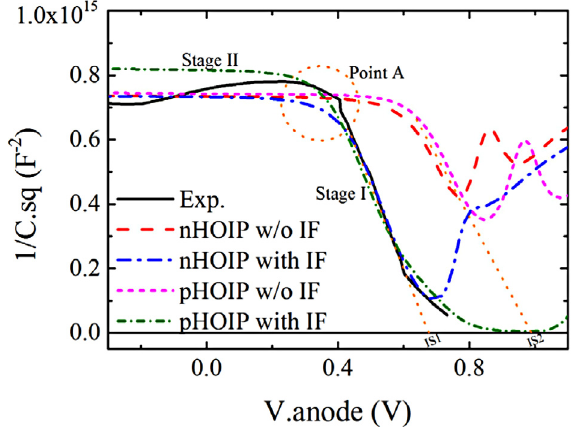
Fig. 4. The computed and experimental (solid line) C - V char- acteristics in dark of HTM-free PSC. N-doped HOIP with (without) an n-doped interfacial layer (IF) at Au/HOIP inter- face is indicated as dash dot (dash) line. P-doped HOIP with (without) a p-doped IF at TiO 2 /HOIP interface is indicated as short dash dot (short dash) line. The V bi values extracted from the IS1 and IS2 intersections are equal to 0.6 and 0.9 V,